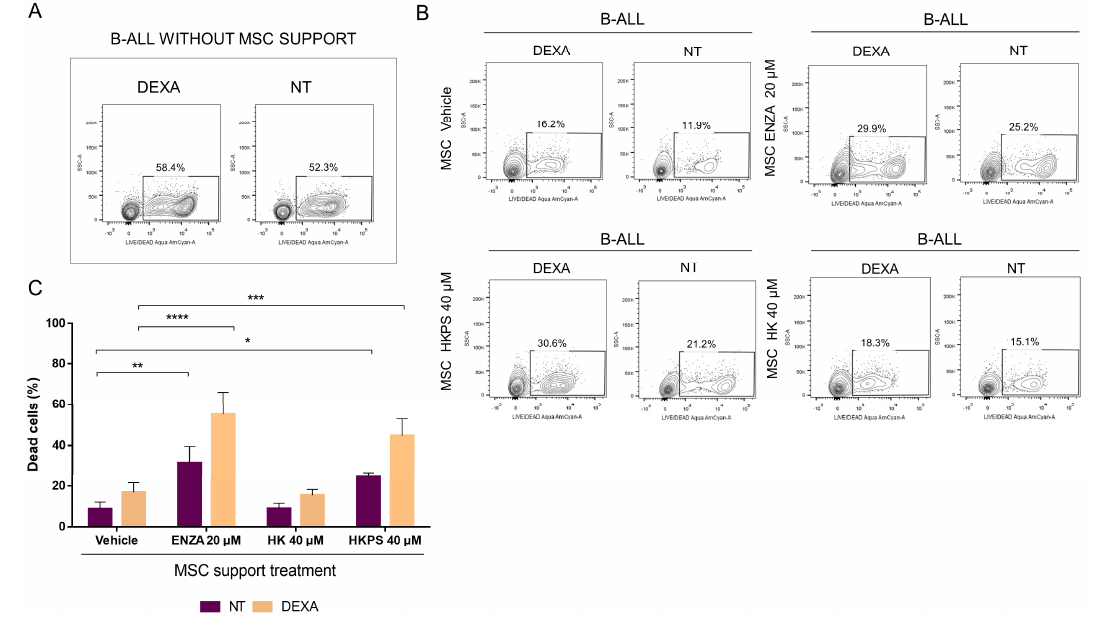
treatment in B-ALL cells. ( A ) Viability of B-ALL cells treated or not with DEXA for 6 h in the absence HK peptides (40 µM) ENZA (20 µM) or vehicle. B-ALL cells exposed or not (NT) to DEXA (250 nM) HK peptides (40 µ M) ENZA (20 µ M) or vehicle. B-ALL cells exposed or not (NT) to DEXA (250